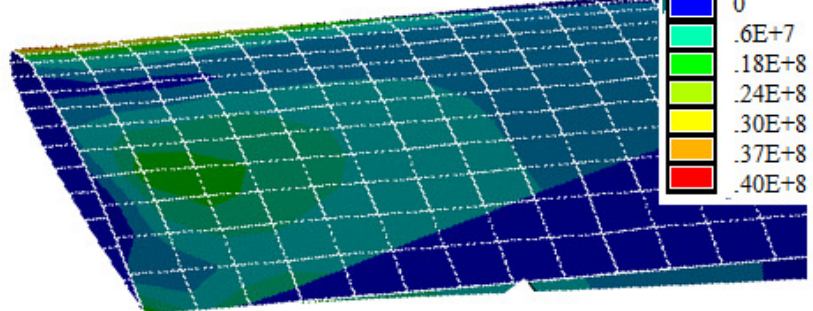
Fig. 2. von Misses stress distribution on